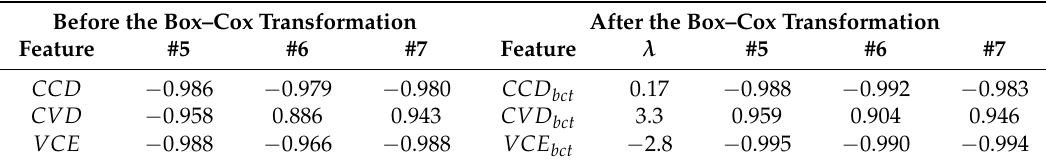
Table 2. Calculation results of the Pearson correlation